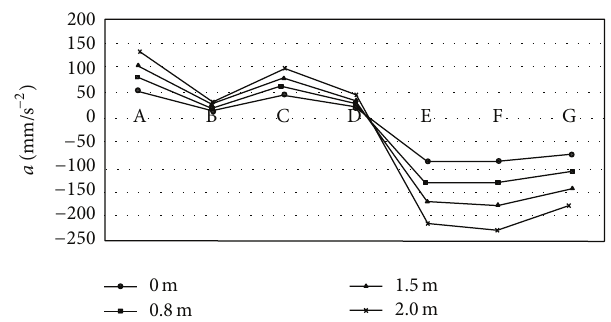
Figure 8: 𝑍 -direction acceleration